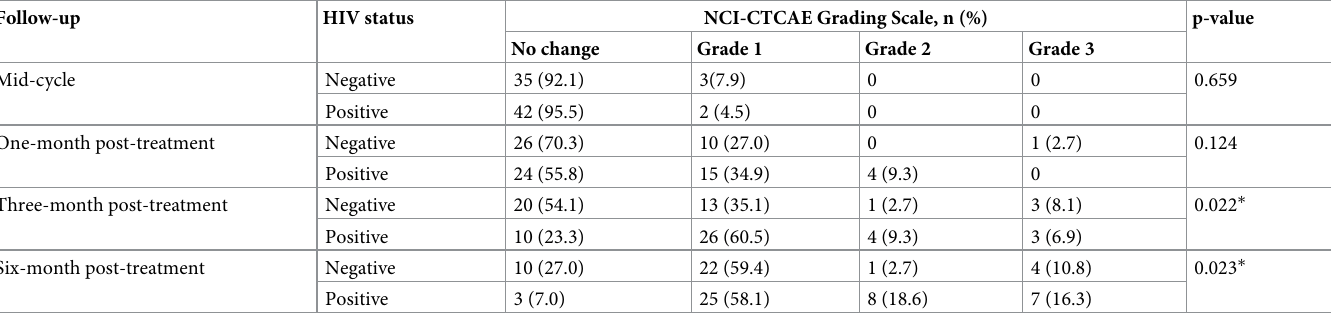
Table 5. Severity of ototoxicity by HIV status at each audiological assessment (NCI-CTCAE Grading Scale). Follow-up